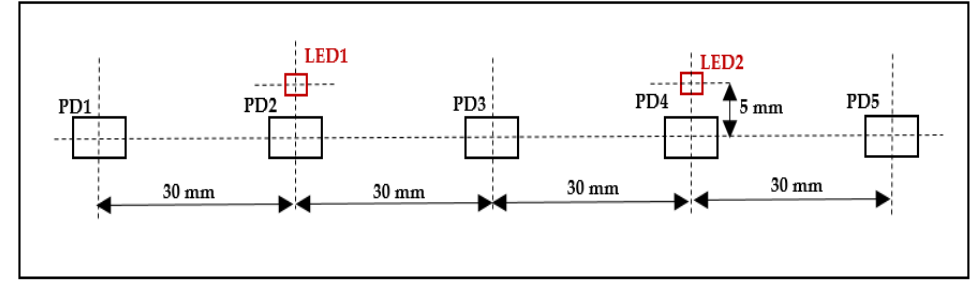
Figure 2. Distance between the LEDs and PDs.